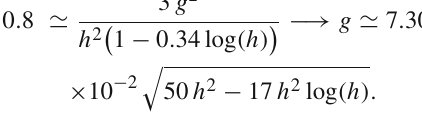
and N = 55(rightpanel).Wecomparetheoreticalpredictionsof ( r , n s ) for different values of C r and keep C 1 fixed with C 1 = 8 . 0 × 10 − 1 with Planck’18 results for TT, TE, EE, +lowE+lensing+BK15+BAO